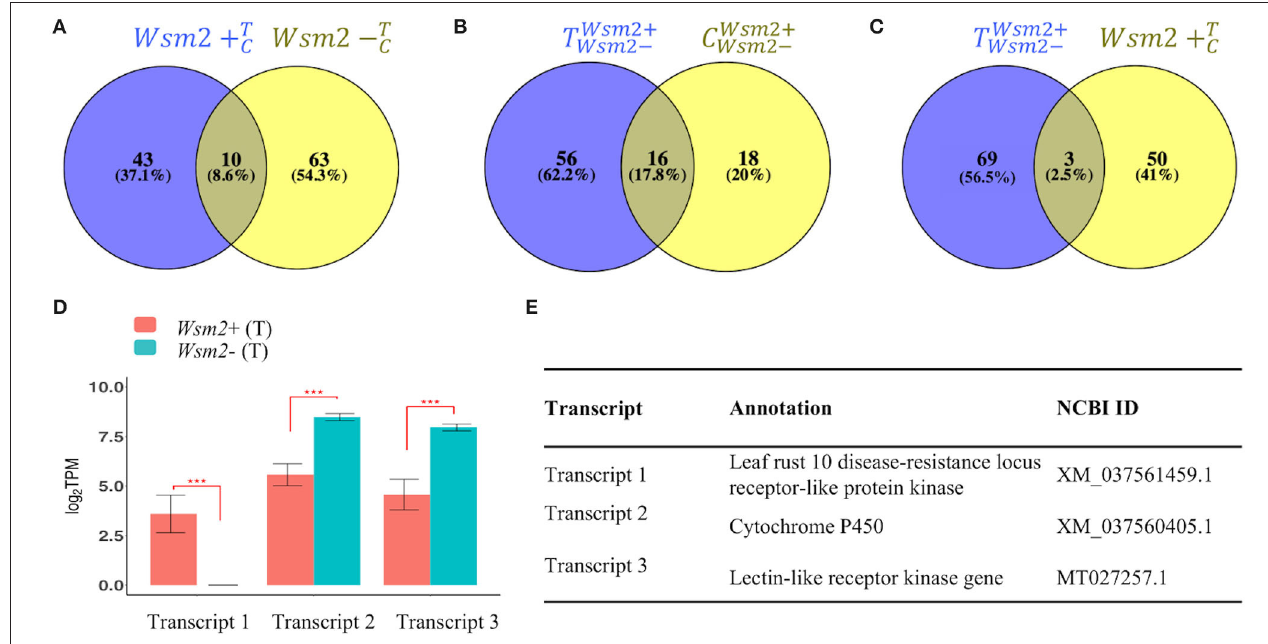
FIGURE 7 | Expression analysis of de novo assembled transcripts absent from “Chinese Spring.” Venn diagrams show the total number of differentially expressed transcripts (DETs) ( P adj < 0.01) between (A) Wsm 2 + T C and Wsm 2 − T C , (B) T Wsm 2 + Wsm 2 − and C Wsm 2 + Wsm 2 − , and (C) T Wsm 2 + Wsm 2 − and Wsm 2 + T C . (D) Expression in Log 2 TPM of three DETs significant in both T Wsm 2 + Wsm 2 − and Wsm 2 + T C contrasts. *** P < 0.001. (E) Annotations of three